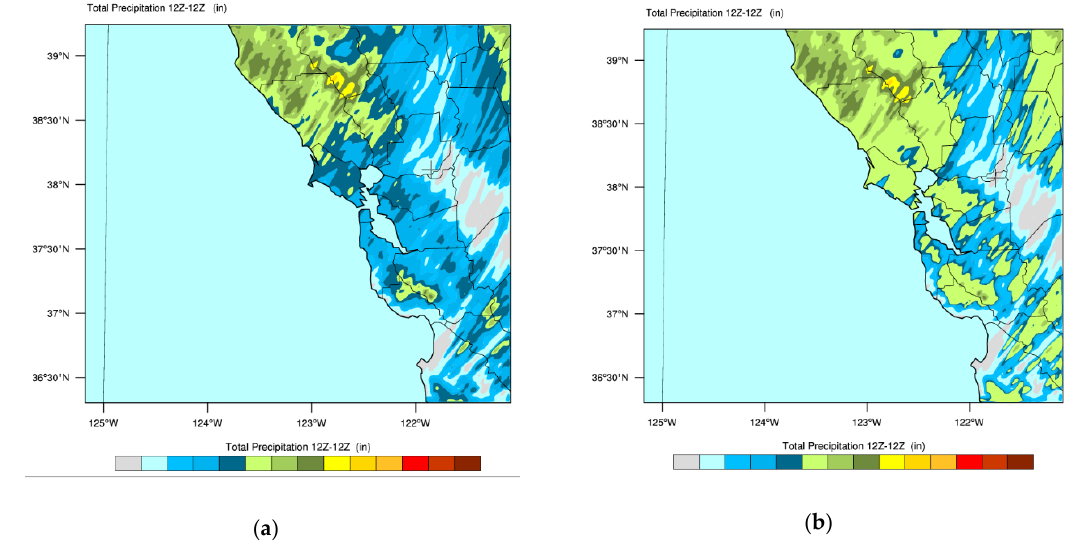
Figure 12. ( a ) left: As Figure 6 but for 12Z–12Z on 30–31 October 2016; ( b ) right: same as above except contour level separating green from blue shading altered to emphasize rainfall pattern as opposed to amount.